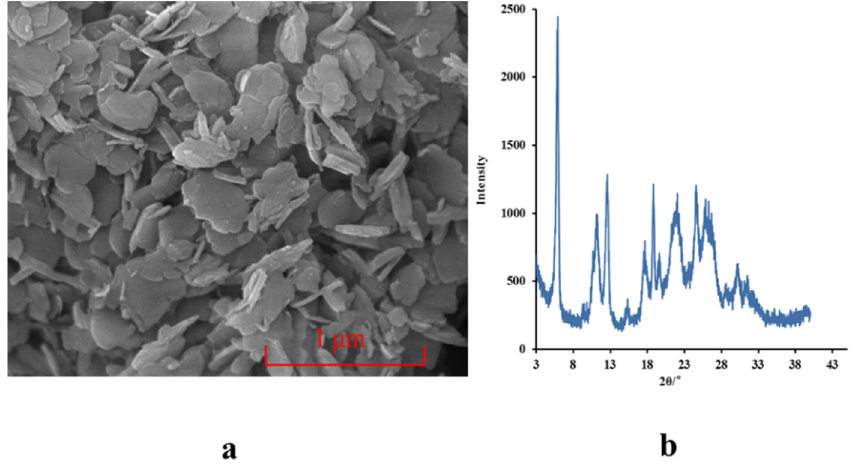
Figure 3. SEM image ( a ) and XRPD pattern ( b ) of icaritin particles prepared without polymers via our RPT. RPT: reactive precipitation technique; SEM: scanning electron microscope; XRPD: X-ray powder